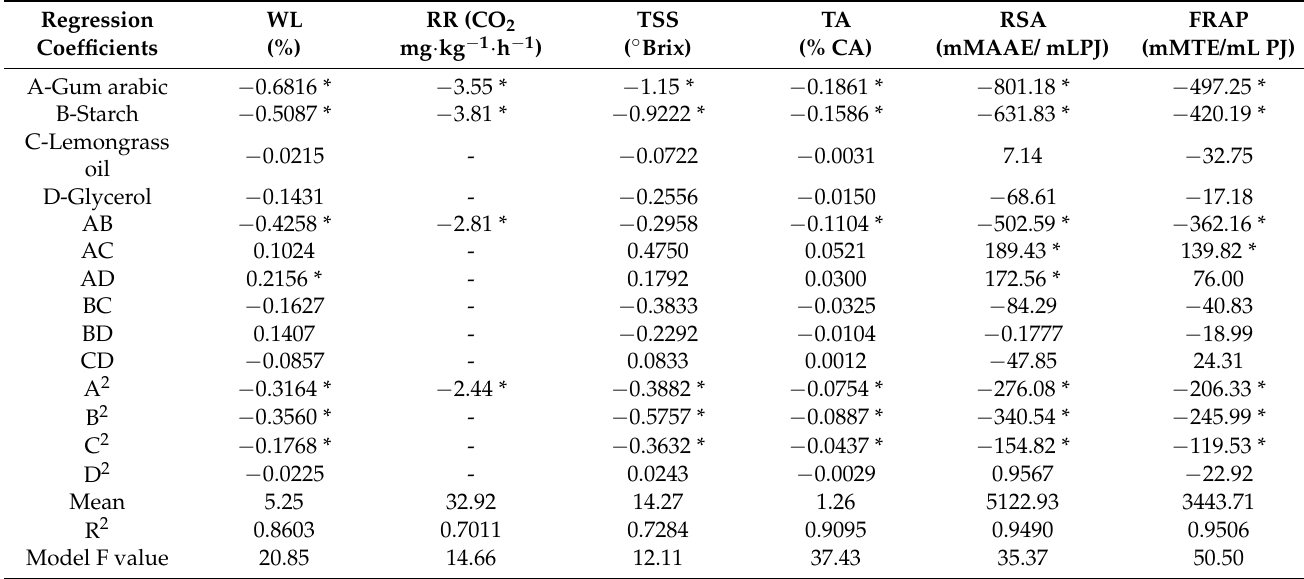
Table 3. The regression coefficients, mean, R 2 and F-values for dependent variables of “Wonderful” pomegranate fruit coated with different concentrations of gum arabic, maize starch, lemongrass oil, and glycerol (WL—weight loss, RR— respiration rate, TSS—total soluble solids, TA—titratable acidity, RSA—radical scavenging activity, FRAP—ferric ion reducing antioxidant power).